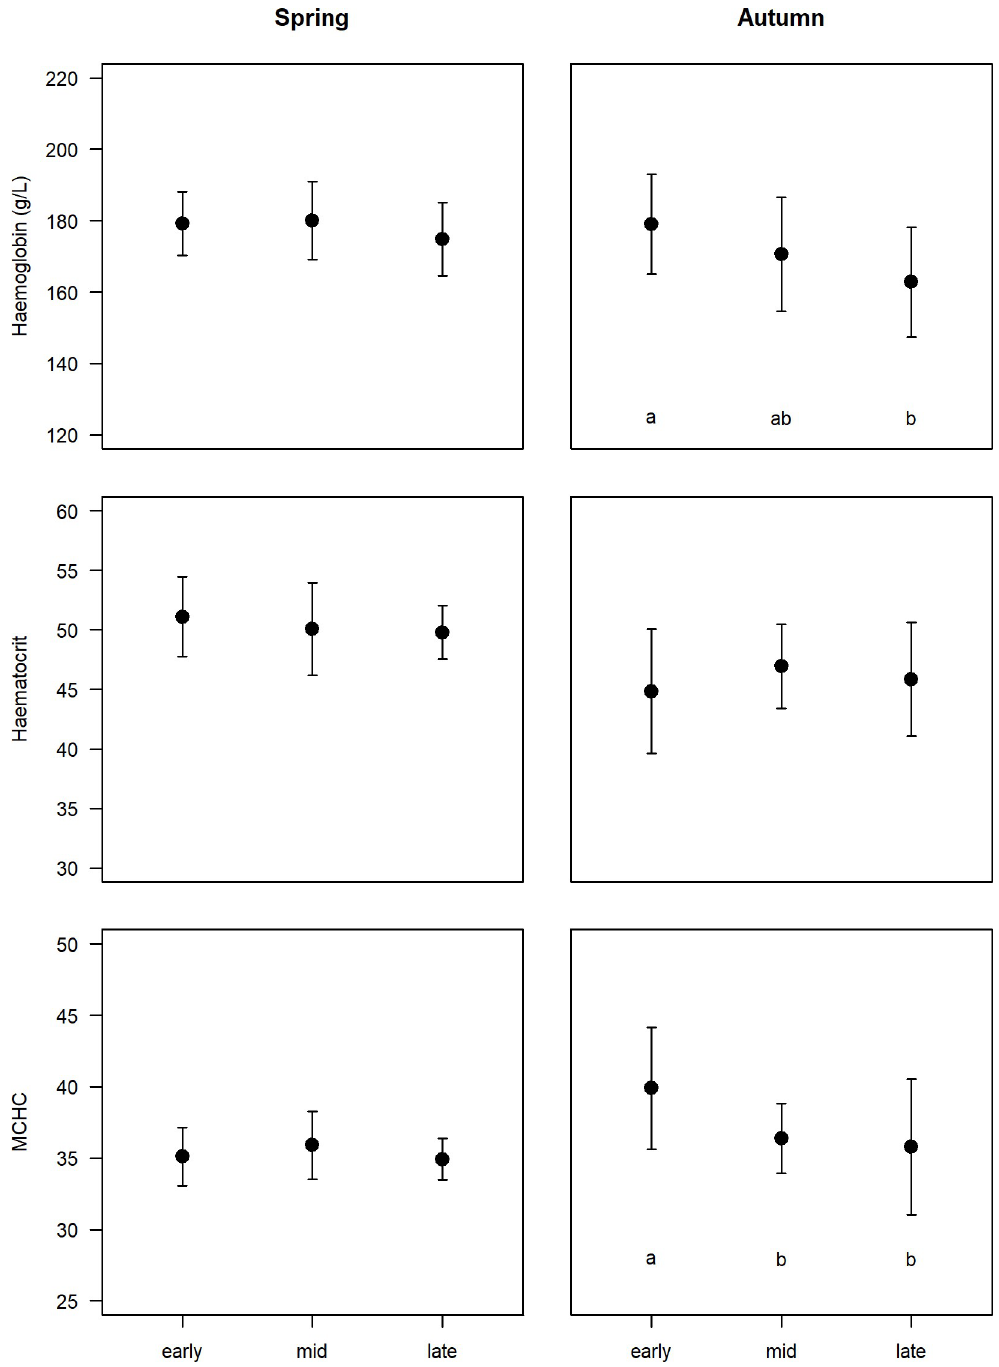
Fig 3. Haemoglobin (Hb), haematocrit and mean cell haemoglobin concentrations (MCHC) in the blood of dunlins during different stages (early, mid, late) of spring and autumn migration. Different letters indicate significant differences between stages (see